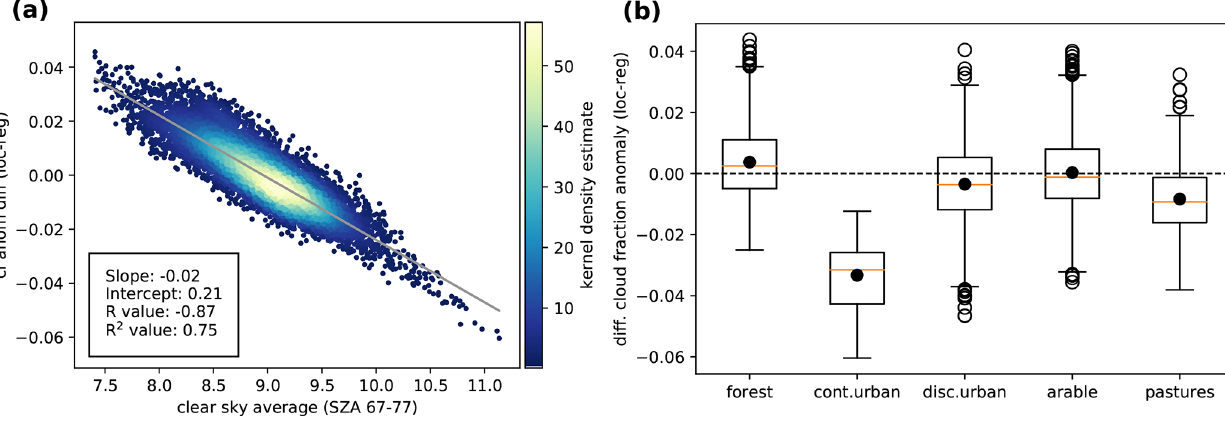
Figure 5. (a) Difference between cloud fraction anomalies (LECDA–RECDA) and clear-sky reflectance (average of SZA bins 67–77). Bright colours represent a higher probability density of the data points using Gaussian kernels. (b) Difference between cloud fraction anomalies (CF loc anomaly − CF reg anomaly) from local and regional empirical cloud detection approaches grouped by five main CORINE land cover types: forest, continuous urban fabric, discontinuous urban fabric, arable land and pastures. The median and mean of each class are presented as horizontal orange lines and black dots, respectively. Whiskers are equal to 1.5 times the interquartile range beyond the first and third quartiles. Outliers are shown as black